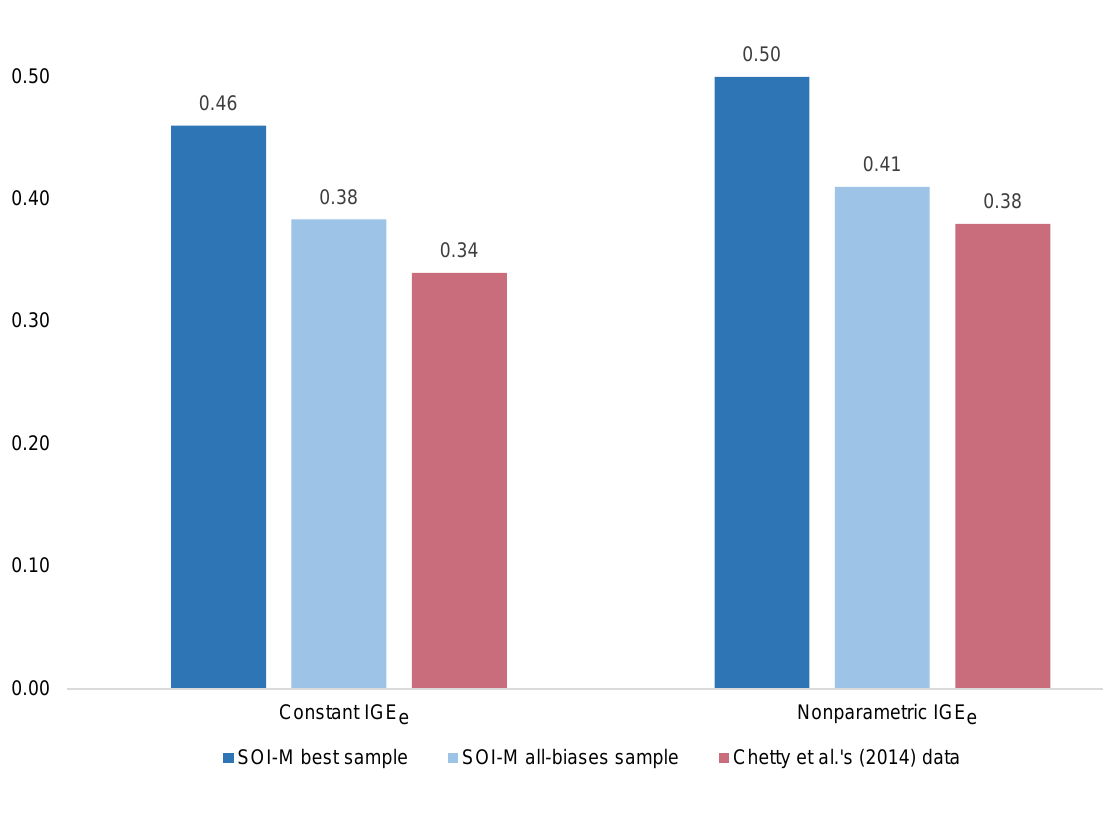
Figure 5: Estimates of the IGE of the expectation based on the SOI-M best sample, the SOI-M all-biases sample, and Chetty et al.’s (2014)